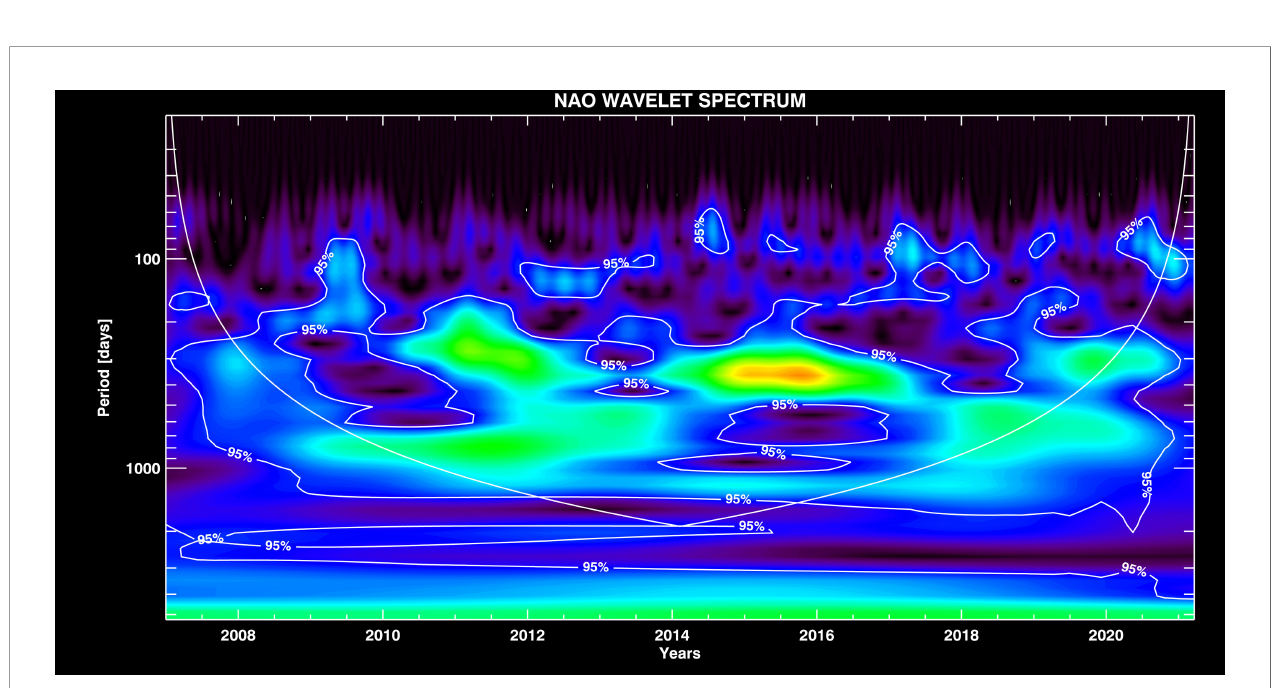
FIGURE 5 | WT of the NAO signal with overplotted contours of the signi fi cance interval of 0.95 %, and the con fi dence interval (COI) curve.